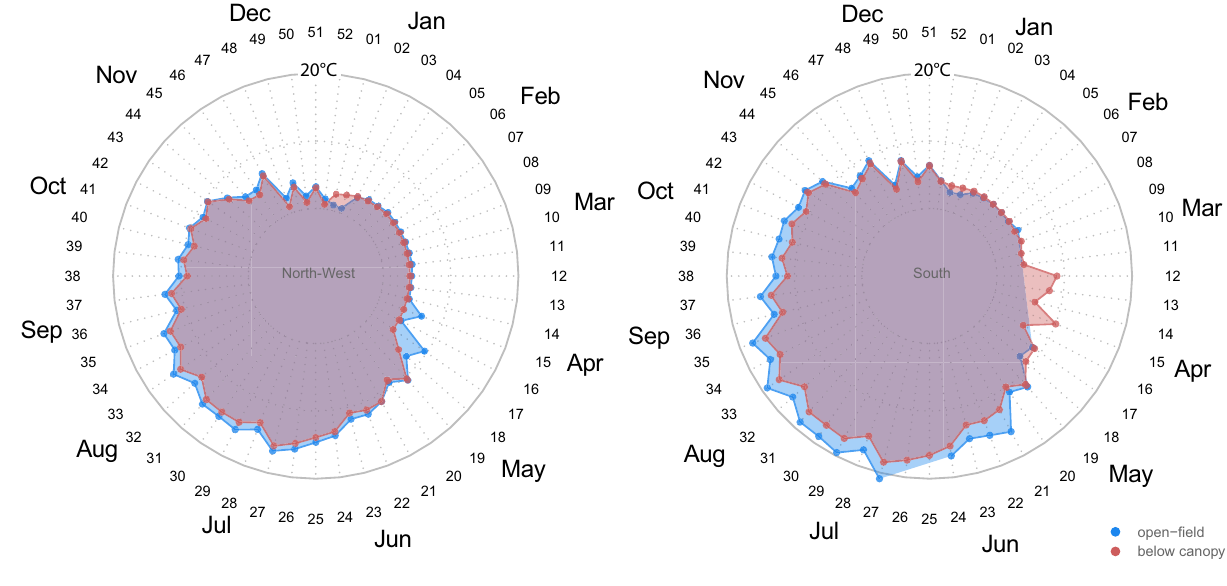
Figure 4. Average weekly near-ground air temperature recorded in the open field (blue) and below the forest canopy (red) on North-West (left) and South (right) aspects. Black numbers in the radar charts are the week number while gray numbers are the temperature (in °C).